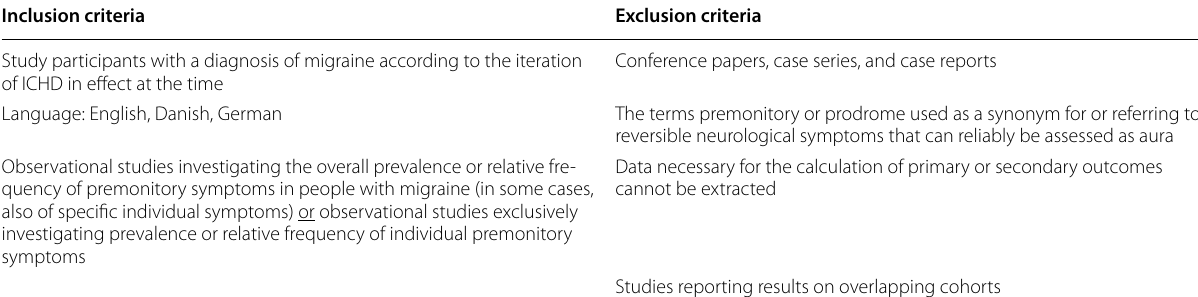
Table 1 Eligibility criteria for study inclusion Inclusion